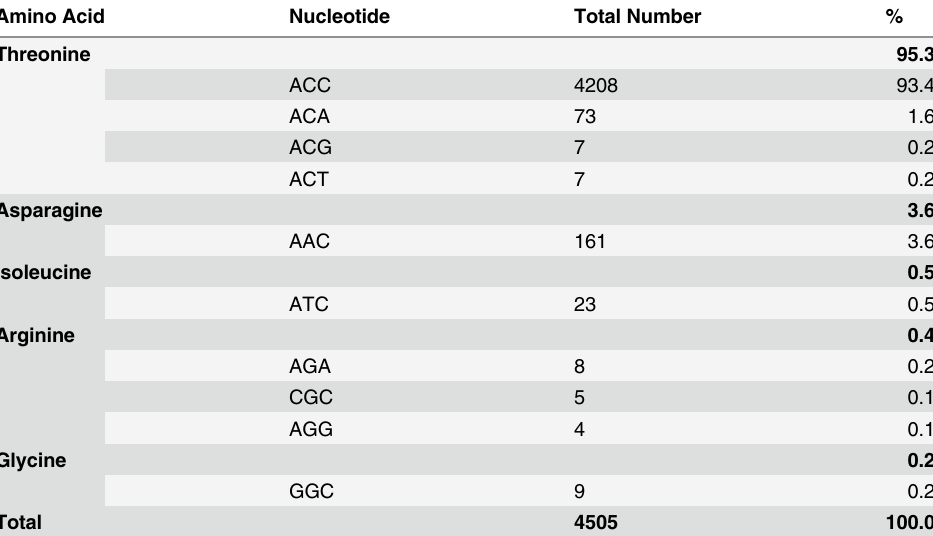
Table 2. Amino acid and nucleotide mutation frequency of 4,505 katG 315 (wild type AGC) isolates. Amino